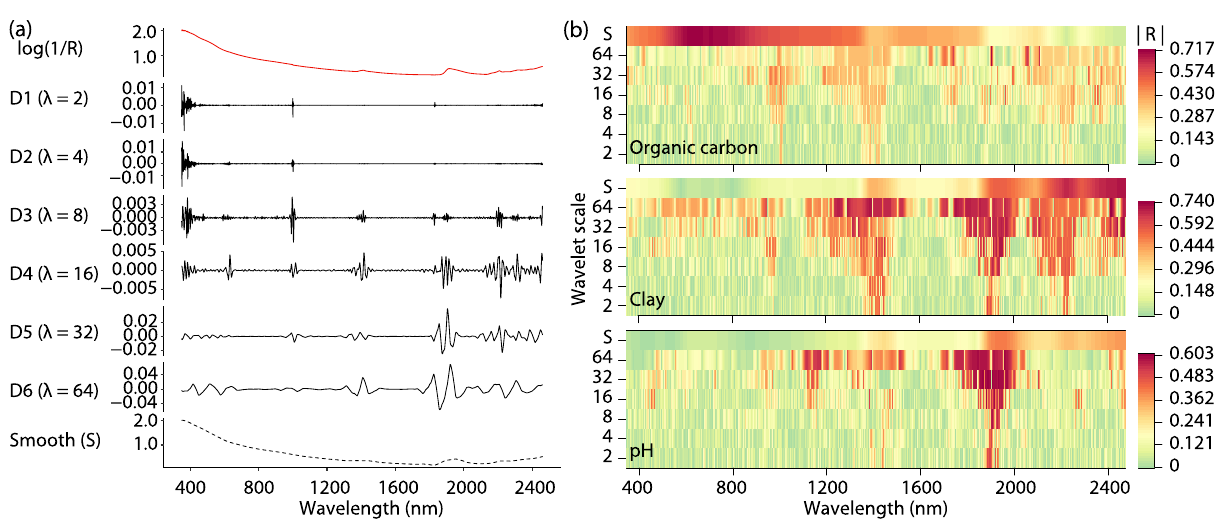
Figure 2. Multiresolution analysis of vis–NIR spectra: Smooth component (S) and details (Di, i = 1, 2, 3, 4, 5, 6) at different wavelet scales ( a ), and absolute values of correlation coefficients between soil properties (organic carbon, clay and pH) and wavelets of vis–NIR spectra ( b